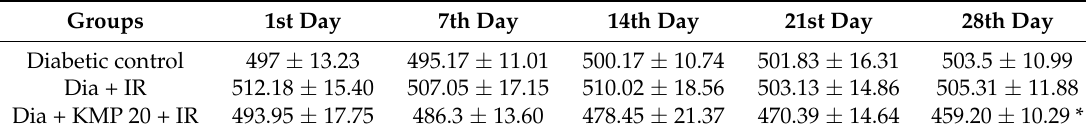
Table 2. Effect of kaempferol on blood glucose level. Data are expressed as mean ± S.E.M.; n = 6 in each group. * p < 0.05 vs. Diabetic control and Dia + IR